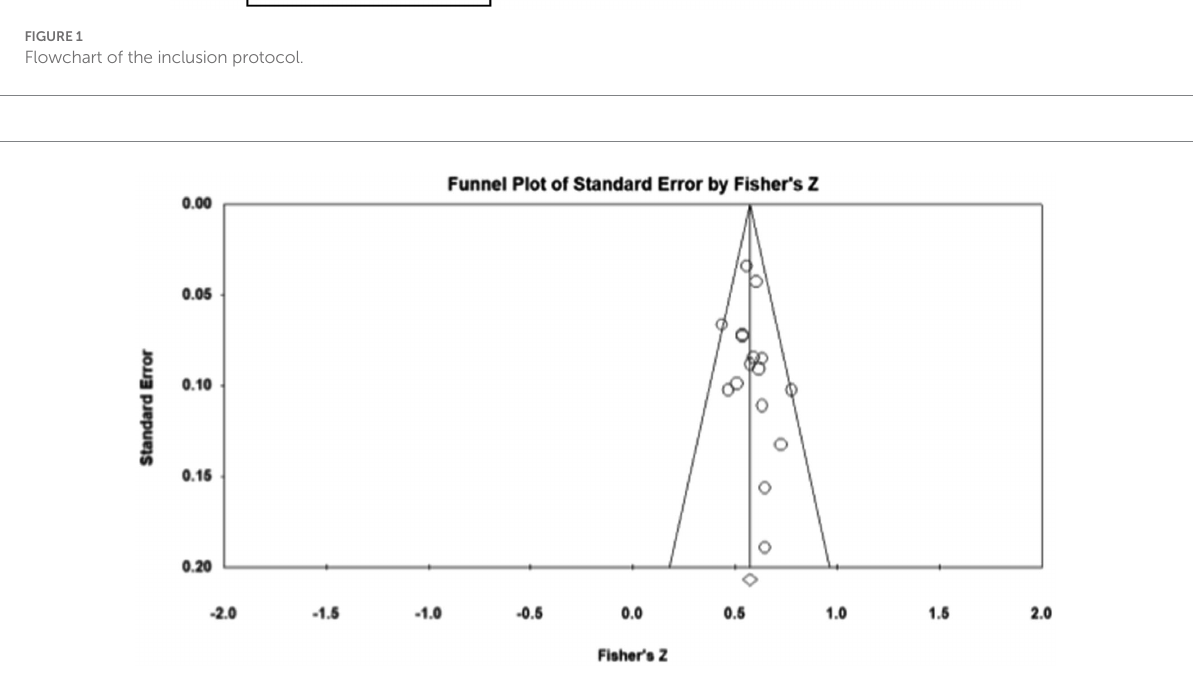
FIGURE 2 Funnel plot. Executive